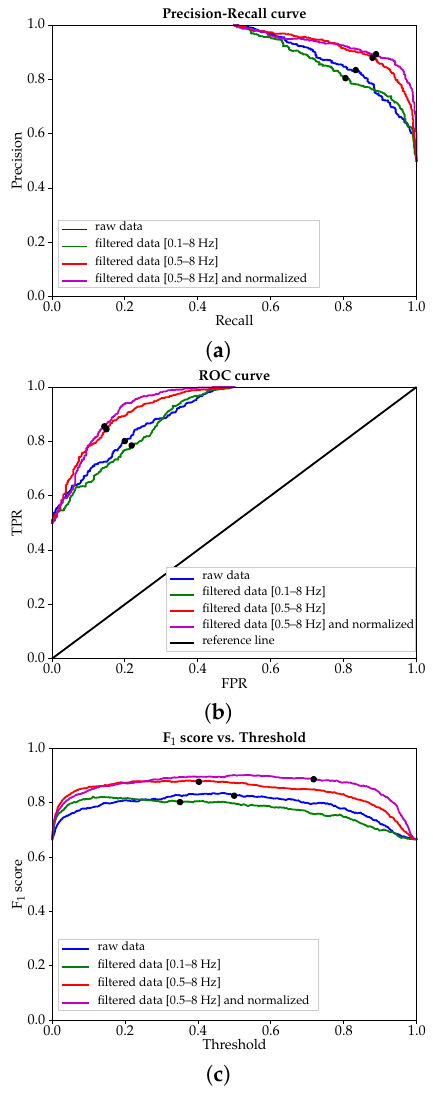
Figure 4. Functional efficiency curves in the case of leaving 40% of users out of training. The working points of the EER curve (see Figure 3) are tagged with the symbol • : ( a ) precision-recall curve; ( b ) ROC curve; ( c ) F 1 score–threshold